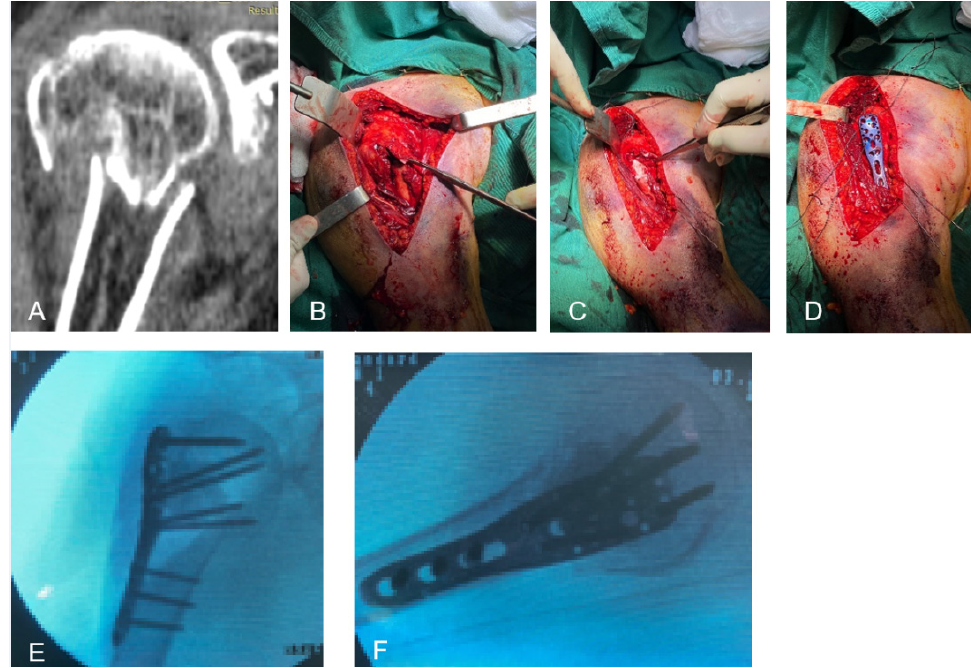
Figure 1. ( A ) Preoperative computed tomography scan with bone impaction and metaphyseal void; ( B , C ) intraoperative images with metaphyseal void and PMMA cement placement through the lateral window; ( D ) plate positioning; ( E , F ) anteroposterior and lateral intraoperative X-ray images.